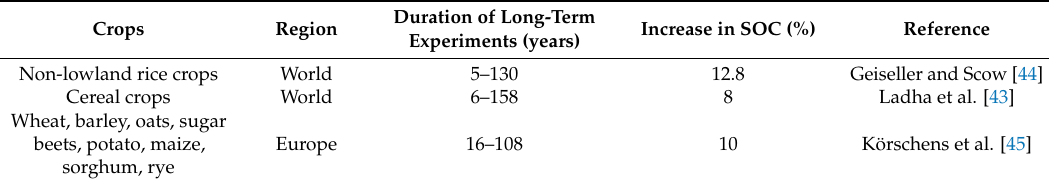
Table 3. Increase in SOC due to fertilizer application as compared to in the unfertilized controls in meta-analysis conducted on long-term experiments from all over the